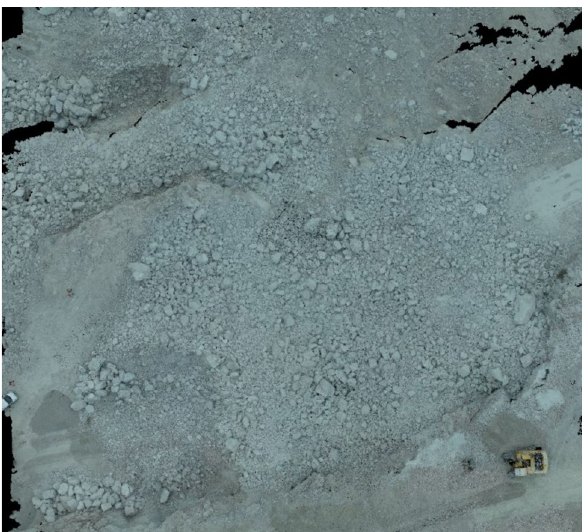
Figure 1. 3D view of limestone quarry after blasting.